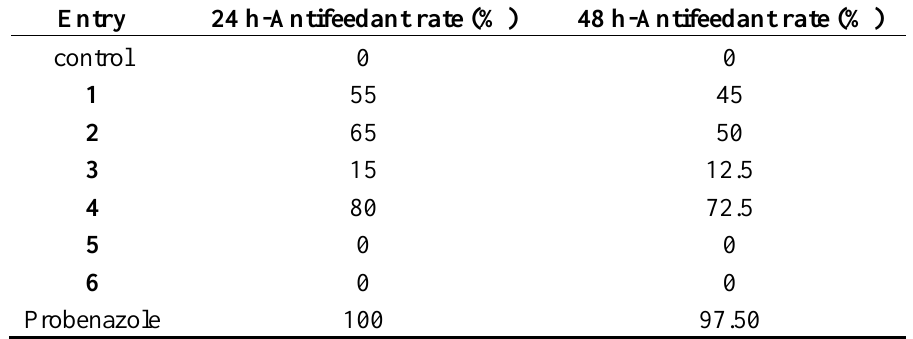
Table 3. Antifeedant effects of compounds ( 1 – 6 ) against 3 rd -instar larvae of M. separata a .